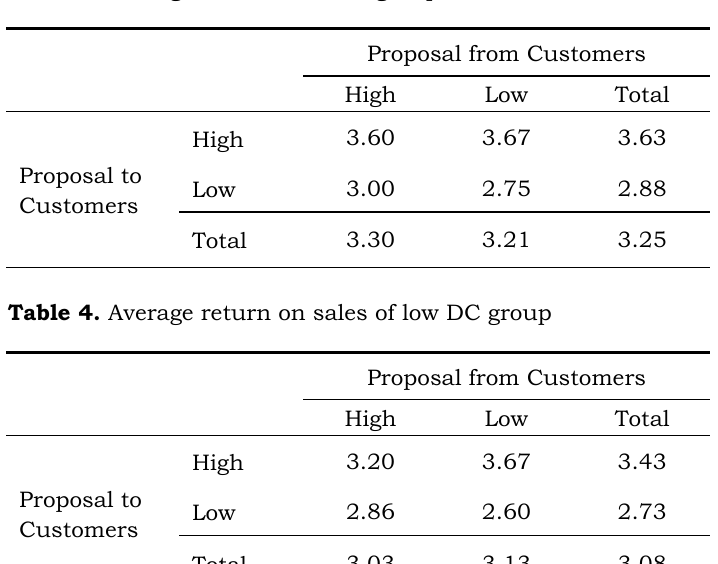
Table 3. Average sales of low DC group